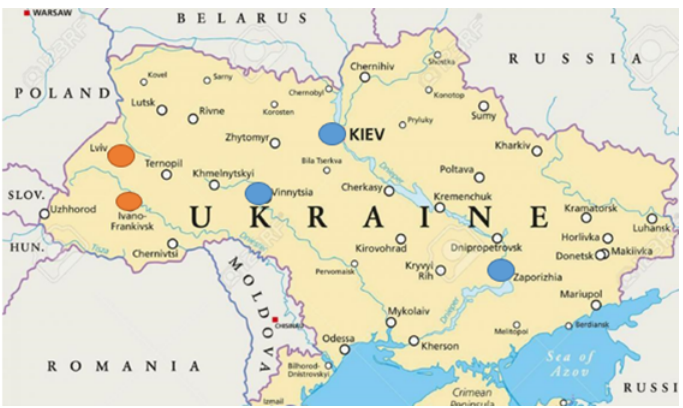
Figure 1 Pollen monitoring points in Ukraine. Orange dots indicate locations where the gravimetric method was used. Blue dots represent locations where the volumetric method was